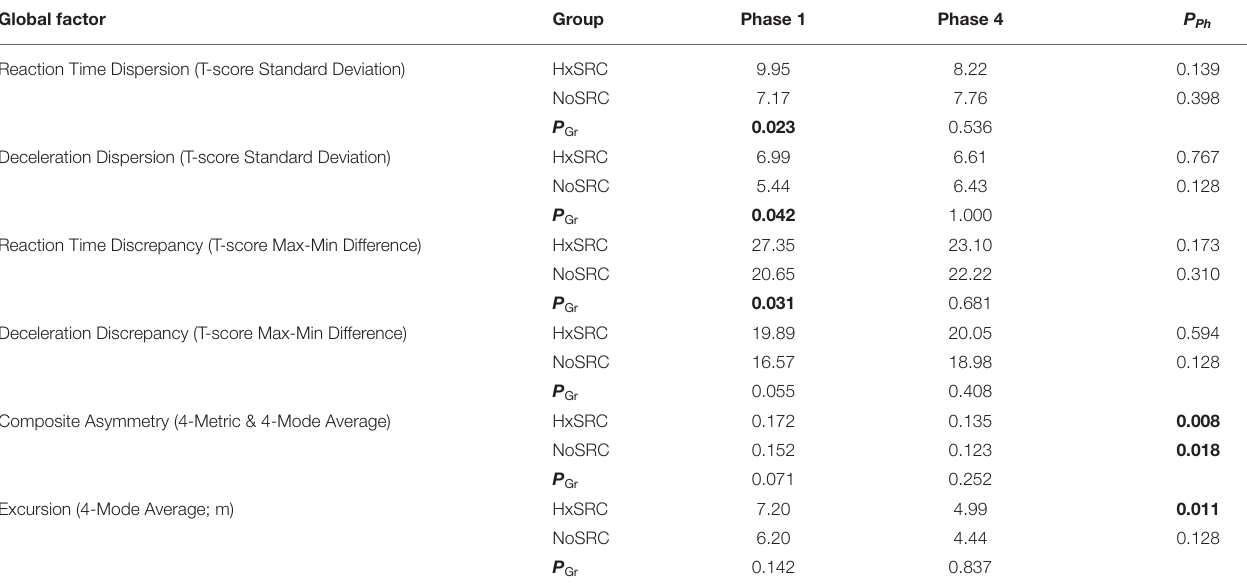
TABLE 10 | Median values for potential high-order indicators of perceptual-motor